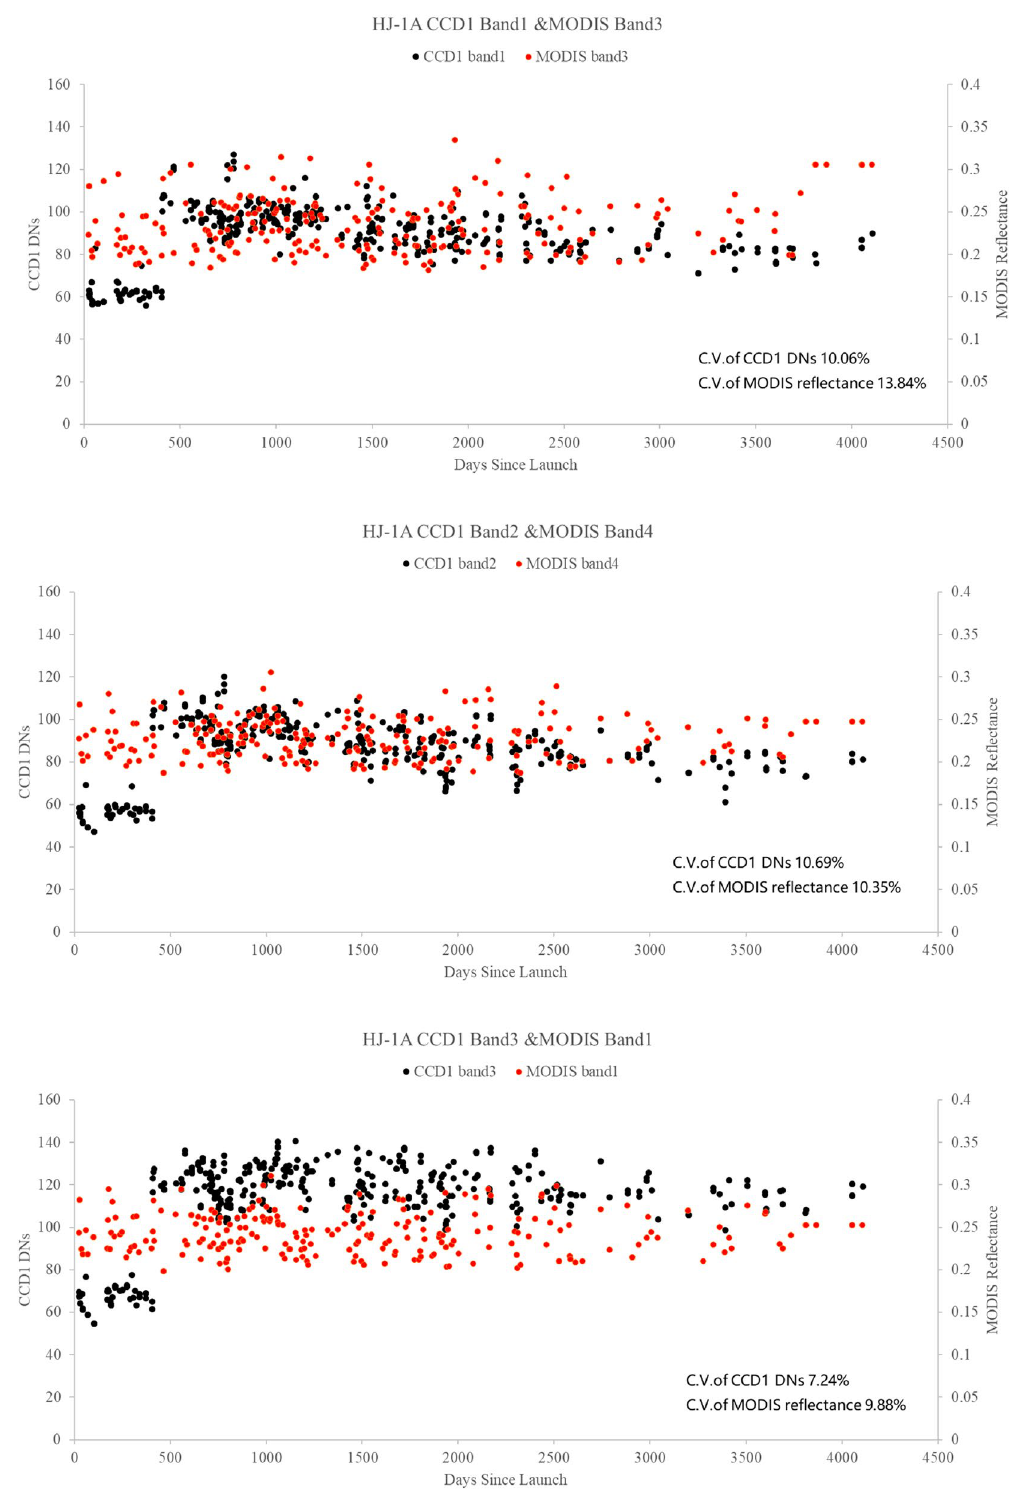
Figure 3. The CCD1 DN and MODIS TOA reflectance determined by the image